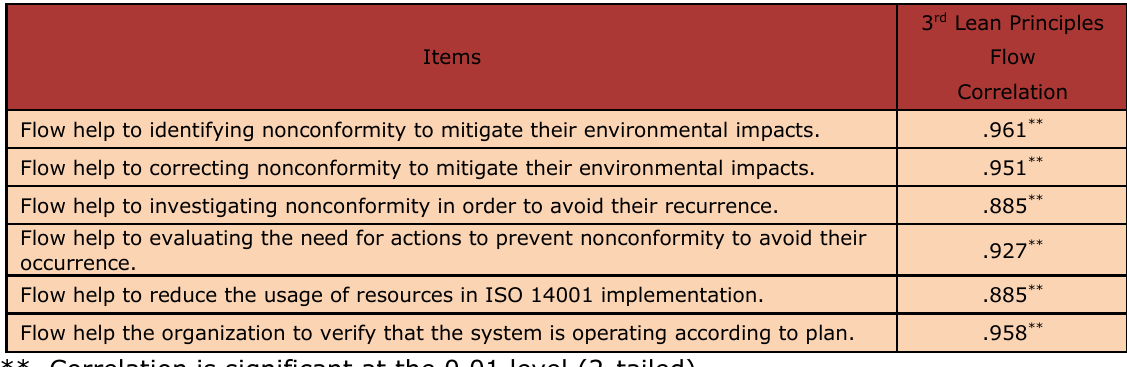
Table 8. Flow with ISO 14001 Requirements